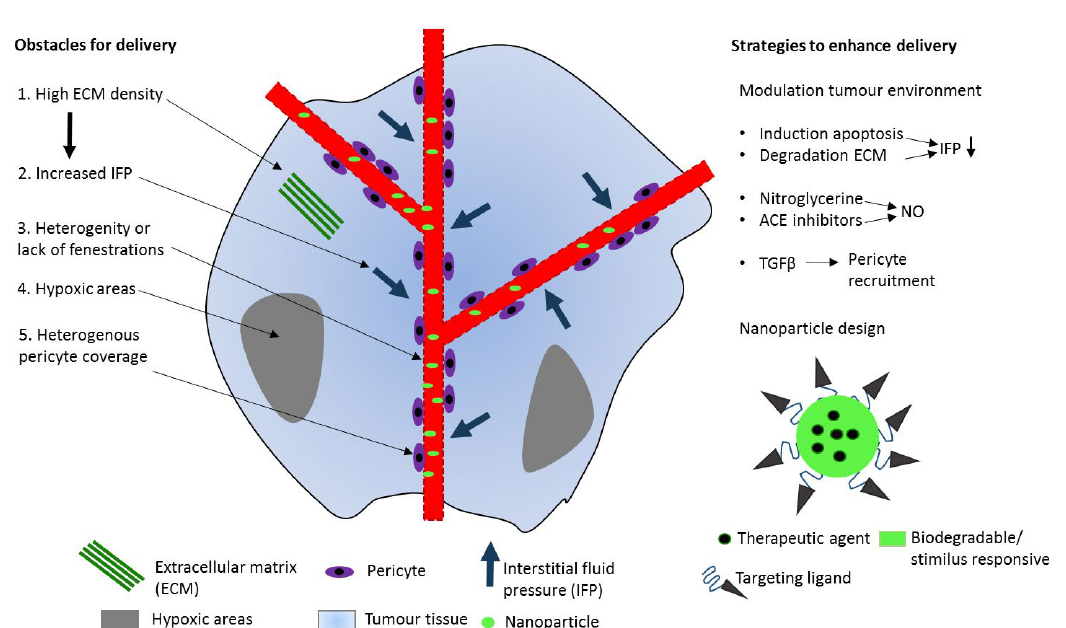
nanomedicine delivery to tumor tissue (left). These five features are distinct from murine tumors and might therefore explain the lower drug delivery efficiency in humans when compared to animal models. Strategies to enhance the EPR effect by modulating the tumor microenvironment (upper right). Drug delivery can also be improved by modifying nanoparticles to increase cellular uptake and drug release at the target (lower right). ACE: angiotensin-converting enzyme; NO: nitric oxide; TGF: transforming growth